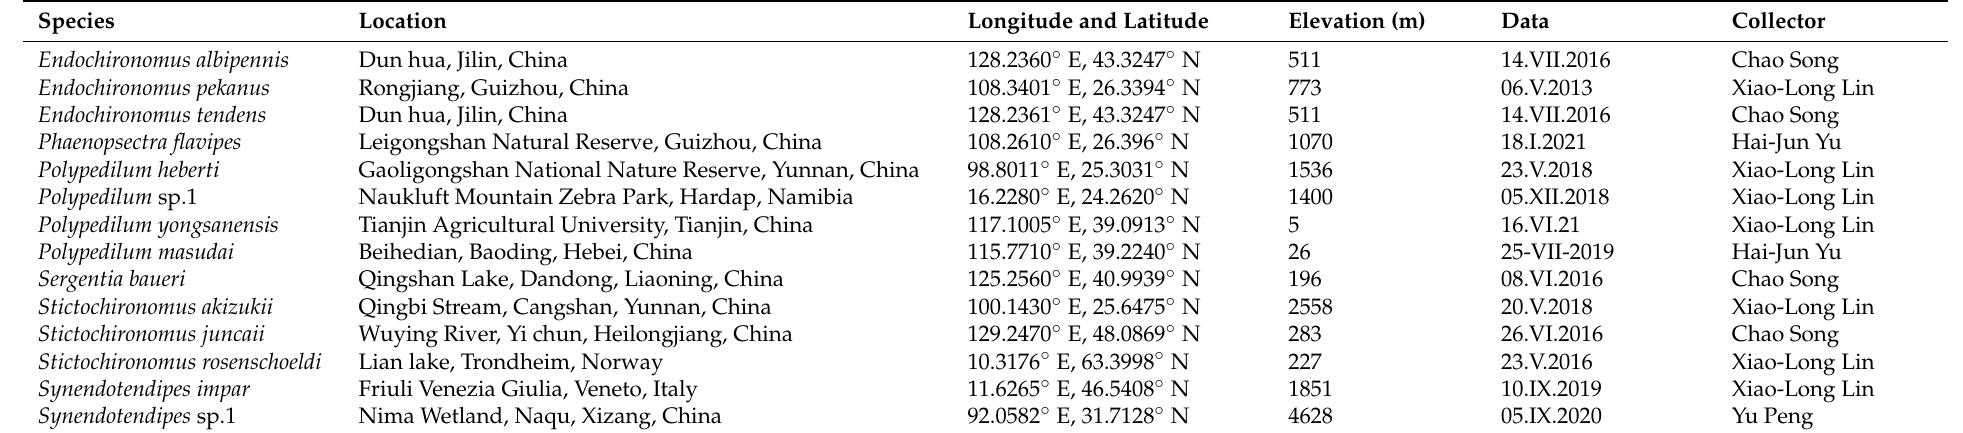
Table 1. Collection information of newly sequenced species in this study.